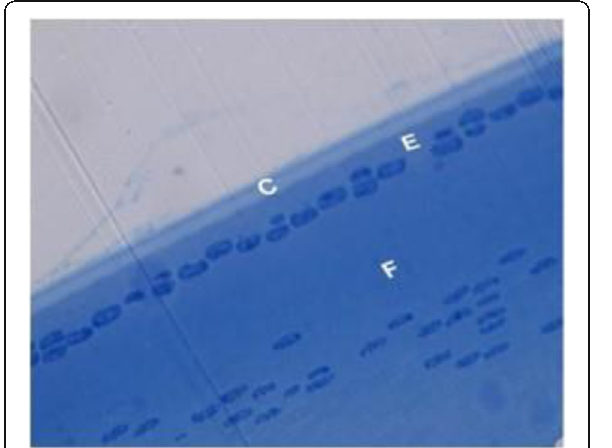
Fig. 9 Light micrograph of rat control lens at the equator showing capsule (C), lens epithelium (E), and lens fiber cells (F) (toluidine blue × 500)